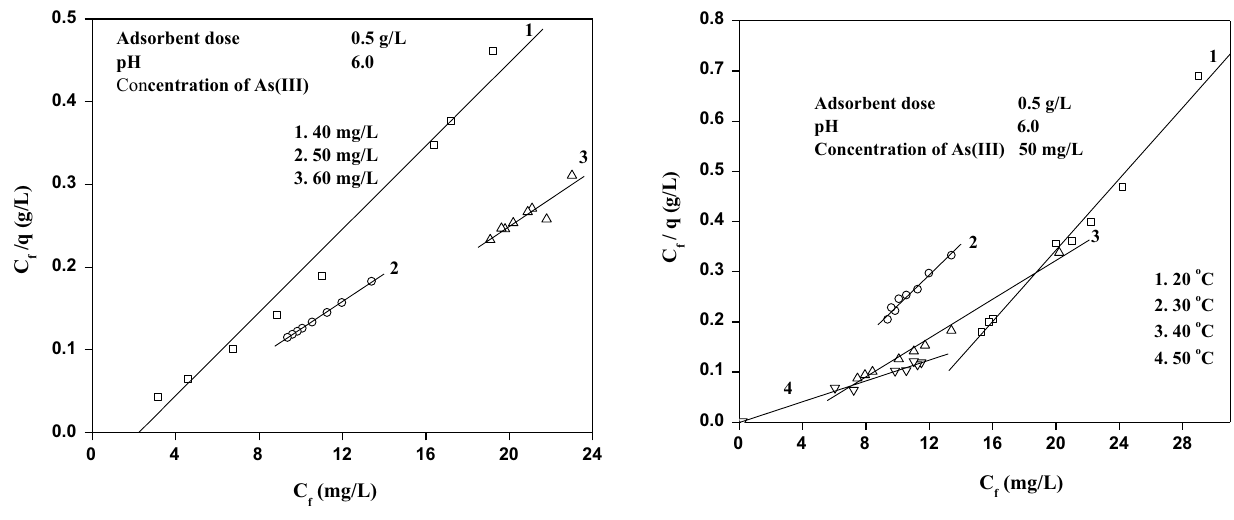
Fig. 5 Langmuir isotherm for As(III) adsorption at different concentrations and temperatures